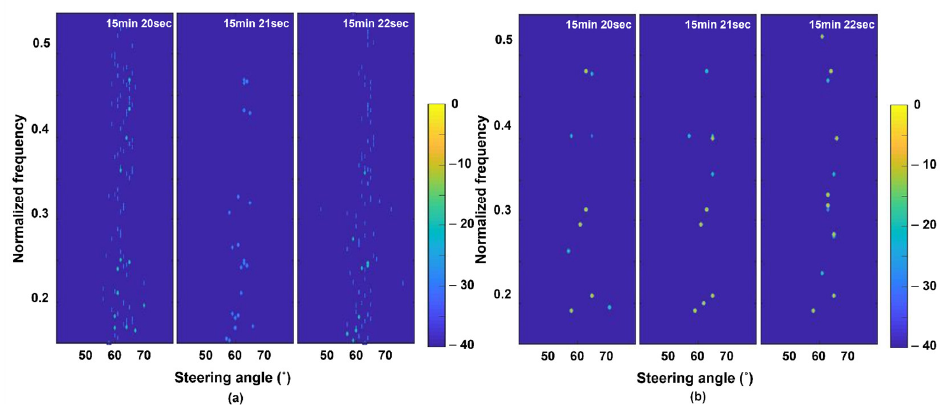
Figure 6. Refined frequency-azimuth plots of ( a ) conventional detection method; ( b ) proposed detection method using the MM-SBL.